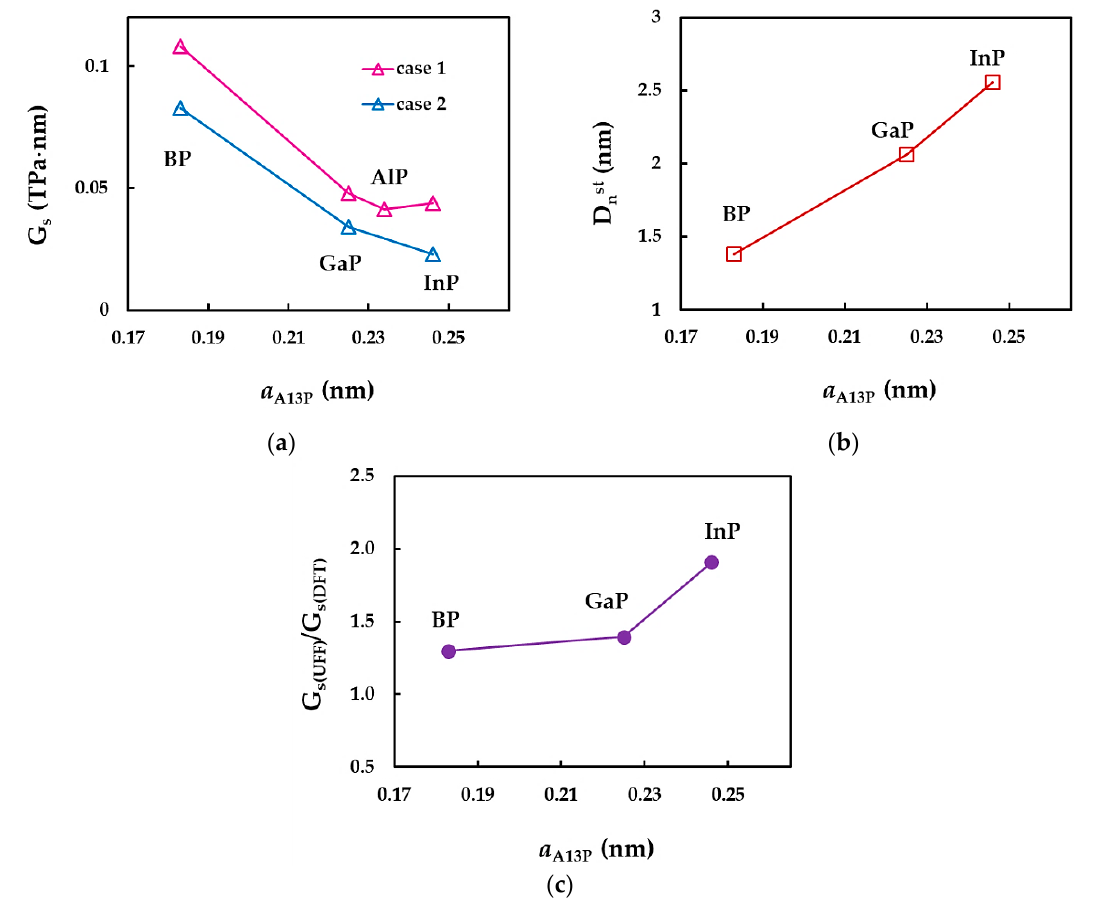
Figure 16. Evolutions of the: ( a ) surface shear modulus, G s , for the two cases of input parameters, ( b ) NT diameter, D nst , for which G s stabilizes, and ( c ) ratio of the surface shear moduli, obtained for case 1 and 2, G s ( UFF ) /G s ( DFT ) , as a function of the bond length, a A13 − P